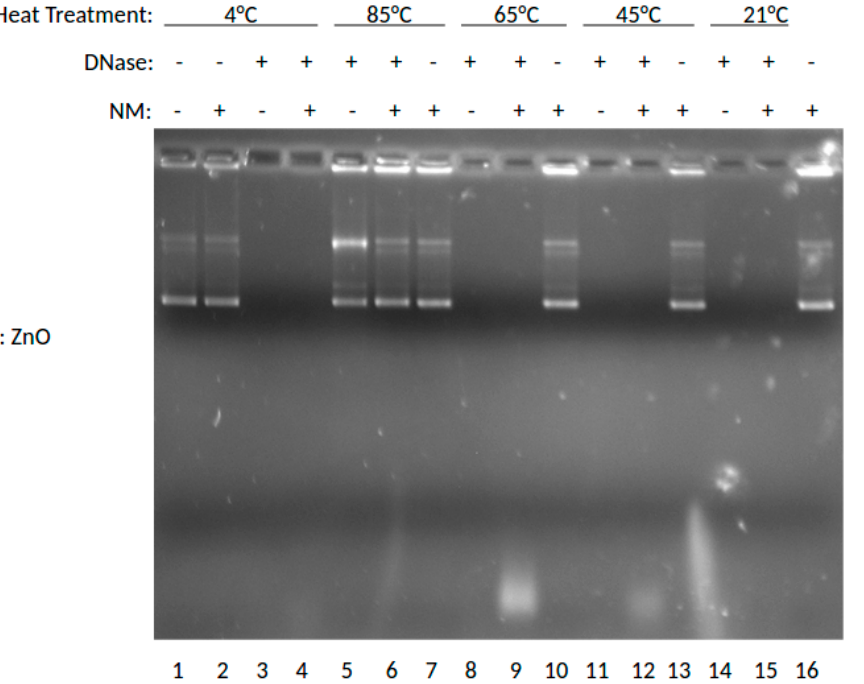
Figure 2. Effects of ZnO on DNase activity at various temperatures shown by gel